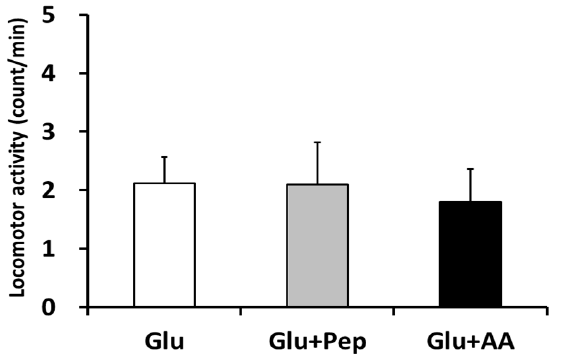
Figure 2. Locomotor activity level during the first 120 min after supplementation. Values are presented as mean ± SEM.